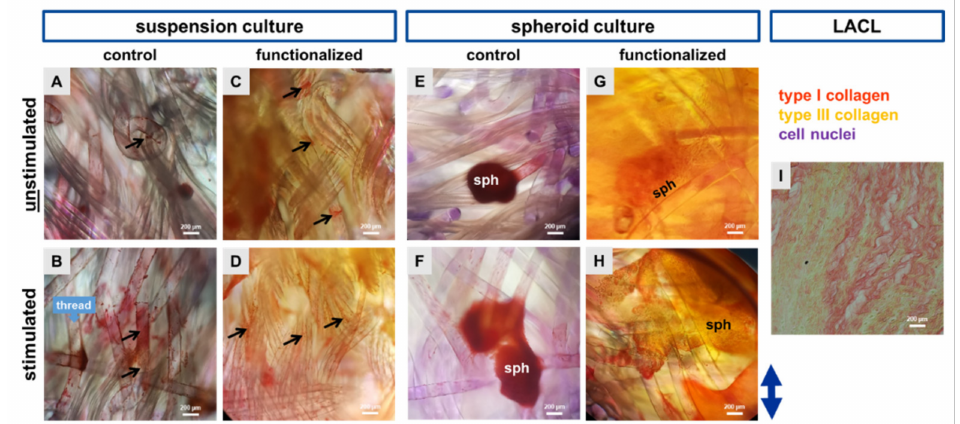
Figure 6. Representative pictures presenting an overview of the colonized scaffolds stained by Sirius Red. Control scaffolds seeded with cell suspension (dynamically pre-cultured for 24 h) either unstimulated ( A ) or stimulated ( B ) and functionalized scaffolds either unstimulated ( C ) or stimulated ( D ). Spheroid (sph) pre-colonized control scaffolds (statical pre-culture for 5 days) either unstimulated ( E ) or stimulated ( F ) and functionalized scaffolds either unstimulated ( G ) or stimulated ( H ). The double headed blue arrow (right side) indicated the stretch direction. The native lapine anterior cruciate ligament (LACL) is shown to see the thicker and mature type I collagen fibers (red-orange), the thinner type III collagen fibers (yellow) and the cell nuclei (violet) ( I ). Scale bars: 200 µ m. The samples of one experiment were stained. Black arrows: pericellular type I collagen staining depicted in